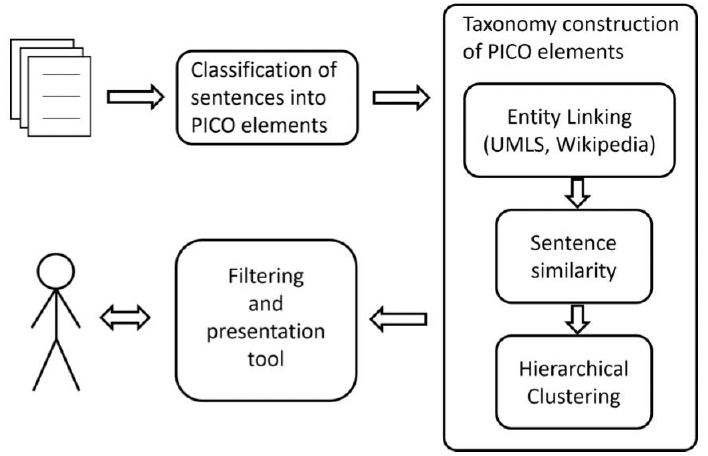
Figure 4. The proposed framework for organizing and filtering the relevant literature based on PICO elements.